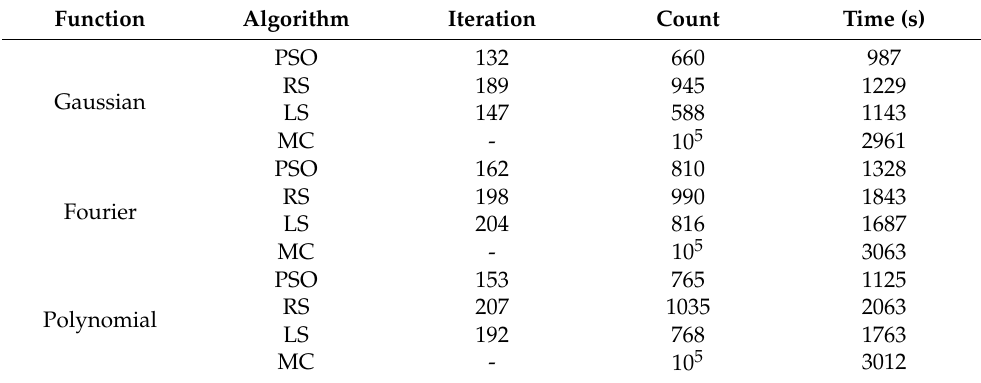
Table 1. The basis function model reliability index of ΔG3.